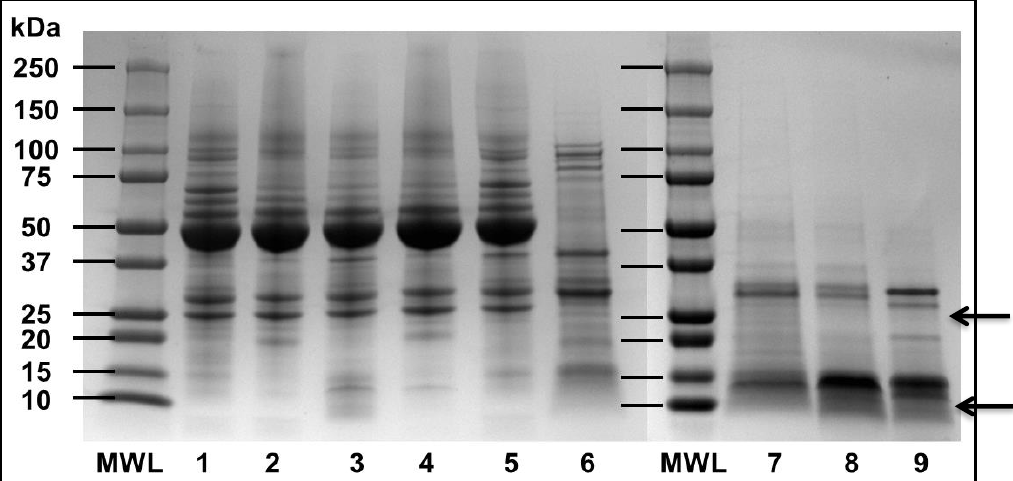
Figure 2. SDS-PAGE (Sodium Dodecyl Sulfate–Polyacrylamide Gel Electrophoresis) of mung bean albumin extracts and 30 kDa MWCO (molecular weight cut-off) filtrates. MWL = molecular weight ladder. ( 1 ) Water pH = 7.5 extract, ( 2 ) Albumin isolate from water pH = 7.5 extract, ( 3 ) Water pH = 3.0 extract, ( 4 ) Albumin isolate from water pH = 3.0 extract, ( 5 ) Borate buffer pH = 8.3 extract, ( 6 ) Albumin isolate from borate buffer pH = 8.3 extract. Samples on lanes ( 2 ), ( 4 ) and ( 6 ) were filtered using a 30 kDa MWCO centrifugal filter to produce the permeates on ( 7 ), ( 8 ) and ( 9 ), respectively. Arrows indicate the protein fractions that are most likely to be mung bean albumin according to their molecular weight.